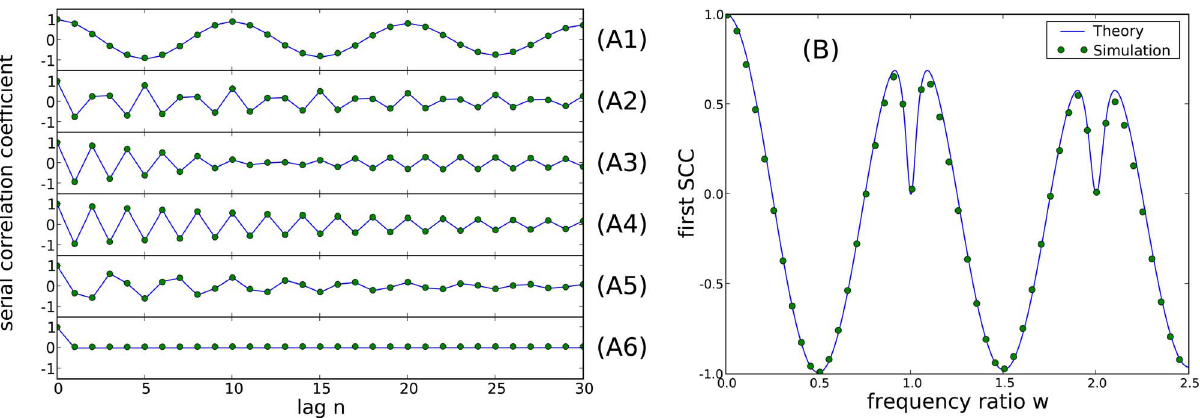
Figure 4. Serial correlation coefficients. A : SCC value (ranging from 2 1 to + 1) as a function of the lag k of interspike intervals, for different values of the frequency ratio: w ~ 0 : 1 (A1), w ~ 0 : 4 (A2), w ~ 0 : 48 (A3), w ~ 0 : 5 (A4), w ~ 0 : 7 (A5), or w ~ 1 : 0 (A6). Parameters: ^ ss x ~ 0 : 1 , ^ ss 2 Dots: simulation. Lines: theory. B : SCC at lag k ~ 1 , r 1 , for highly coherent harmonic noise, as a function of w . Parameters: ^ ss x ~ 0 : 15 , ^ ss 2 Theoretical curves were computed from Eq.(11) and Eq.(12).